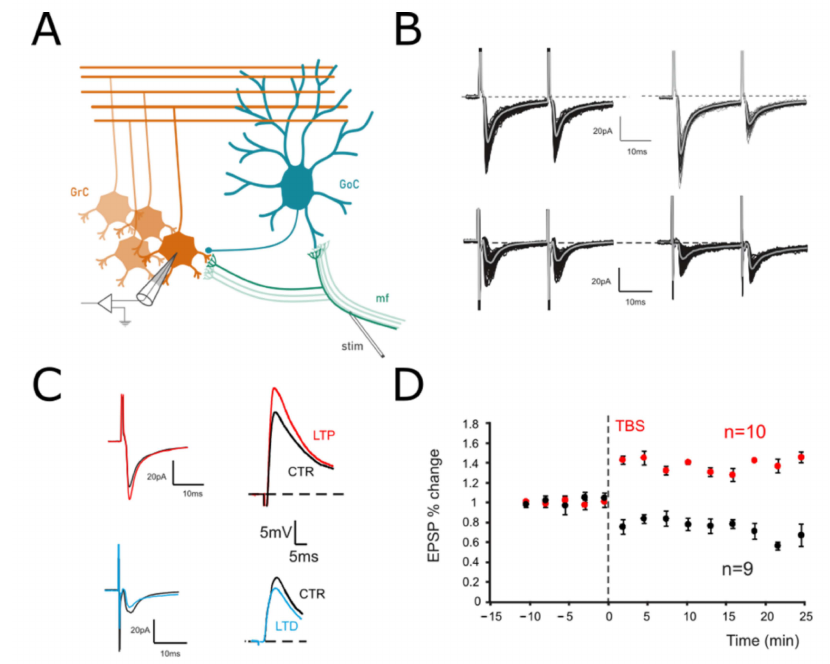
Figure 1. Long–Term Plasticity at the mf-GrC synapse. ( A ) Scheme of the granular layer microcircuit. The stimulating electrode (stim) is positioned onto the mossy fiber bundle (mf) in order to activate excitatory synapses. GoC, Golgi cell (local interneuron); GrC, granule cell (output cell). ( B ) Top . EPSCs elicited in control (left) and following TBS (right) in response to paired pulses at 50 Hz and recorded from a GrC clamped at − 70 mV. In this cell, the TBS induced an increase in the average response, with a marked decrease in PPR. Bottom . In a different cell, EPSCs were evoked before (left) and after (right) TBS from a GrCs voltage clamped at − 70 mV. In this case, TBS evoked a current depression and an increase in the PPR. ( C ) Left . Average responses to the first of the two stimuli shown in B are superimposed to highlight the differences between LTP (red) and LTD (blue). Right . EPSPs elicited by sub-threshold stimuli in the GrCs shown on the left in both the control (black traces) and after LTP (red) or LTD induction (blue). Cells were held at –60 mV (10 superimposed traces). ( D ) Time course of average EPSPs recorded from GrCs at –60 mV in response to TBS delivery. Cells undergoing LTP ( n = 6) are represented in red, while those undergoing LTD are represented in black ( n =